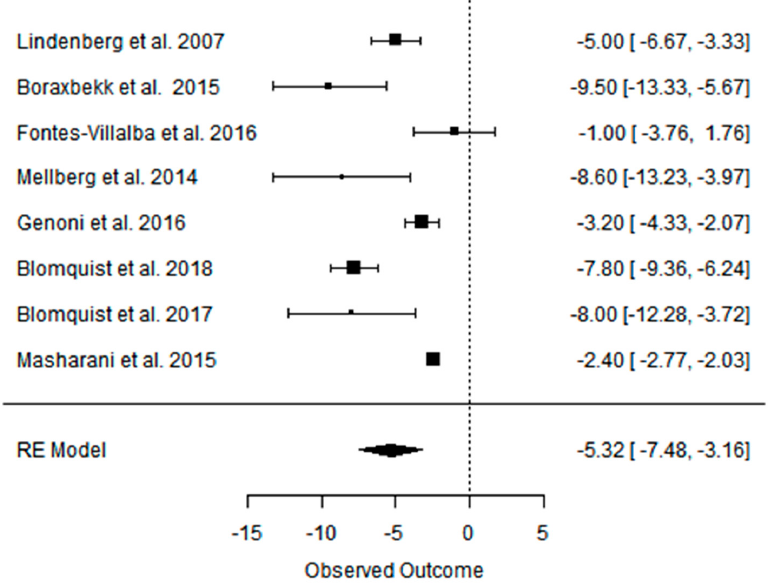
Figure A3. Forest plot of the effect of a CD on BM (kg) in the short term (weighted mean difference).